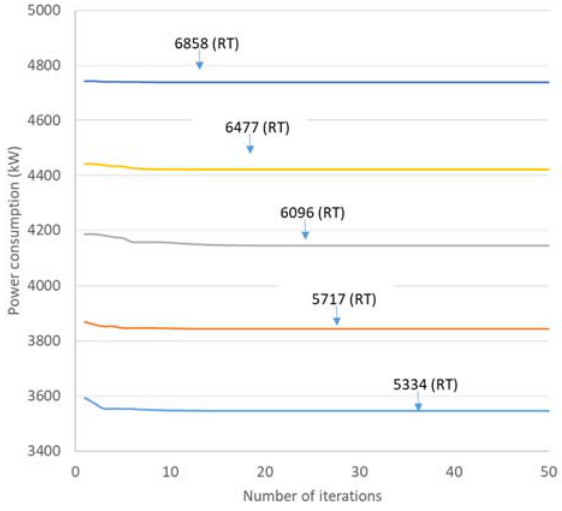
Figure 5. Power consumptions of chillers in Case 2 operated by TPSO algorithm.